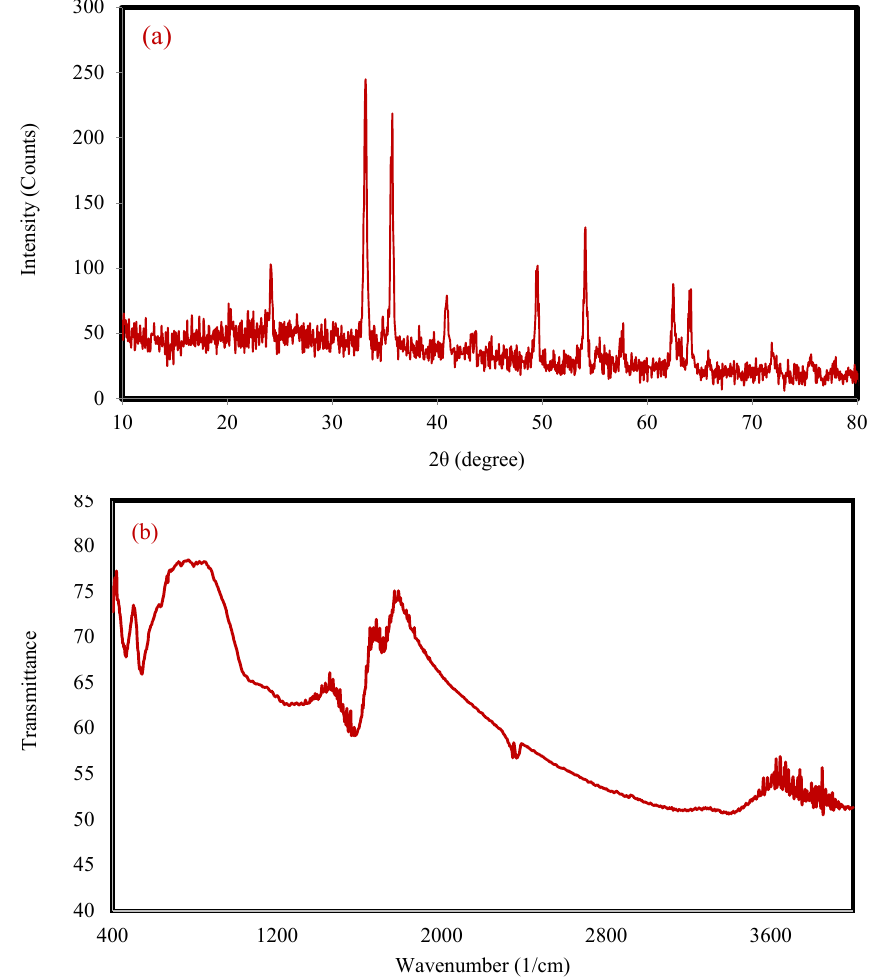
Fig. 8 (a) The XRD pattern, (b) FTIR spectrum, and (c) N2 ads/des isotherm and BJH pore size distribution plot of Fe